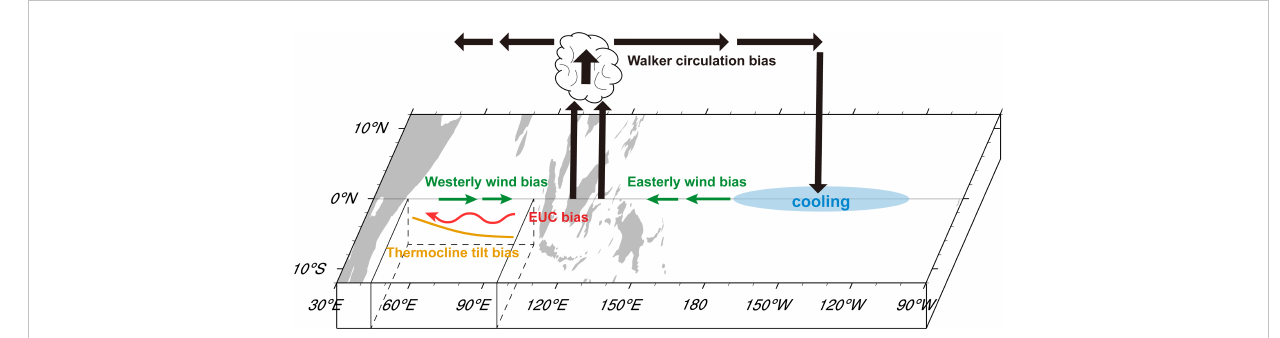
FIGURE 12 Schematic diagram illustrating the origin and physical processes of the Indian Ocean winter – spring EUC bias in the CMIP models. Light blue shading represents the cold SST bias; the green vectors and thick black arrows denote the biases in the simulated surface zonal winds and the related Walker circulation in the CMIP models, respectively. The red arrow and orange curve indicate the simulated EUC bias and thermocline tilt bias,